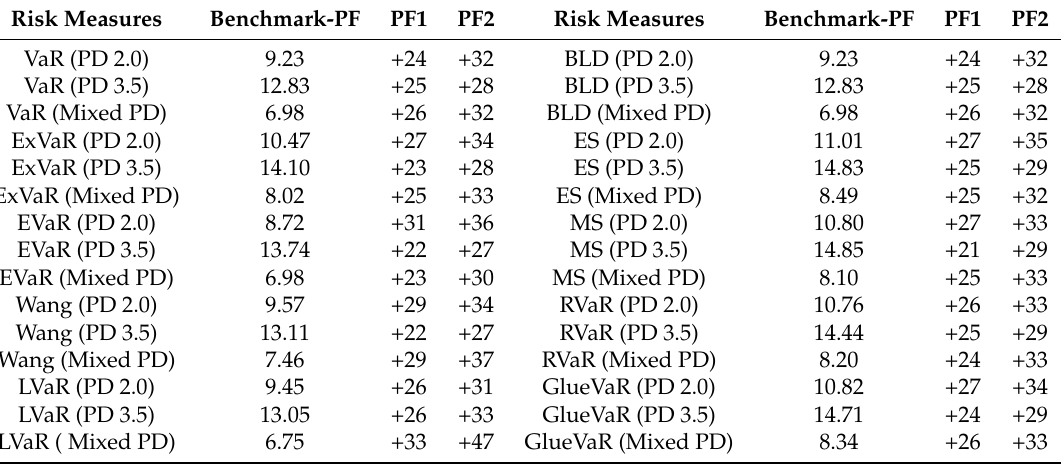
Table 4. Sensitivity analyses of increasing concentration effects